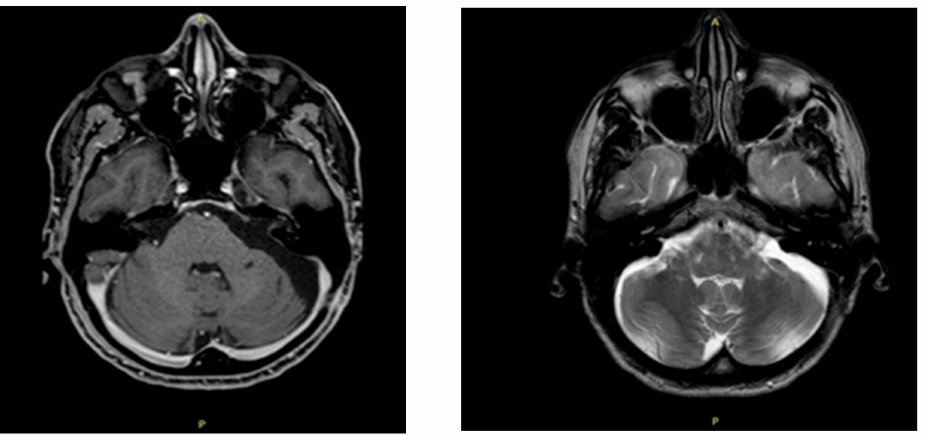
Figure 4. MRI scans after surgery. Notes: T1 weighted sequence ( left ) and SE-T2 weighted scan ( right ). Postoperative MRI scans show complete tumor